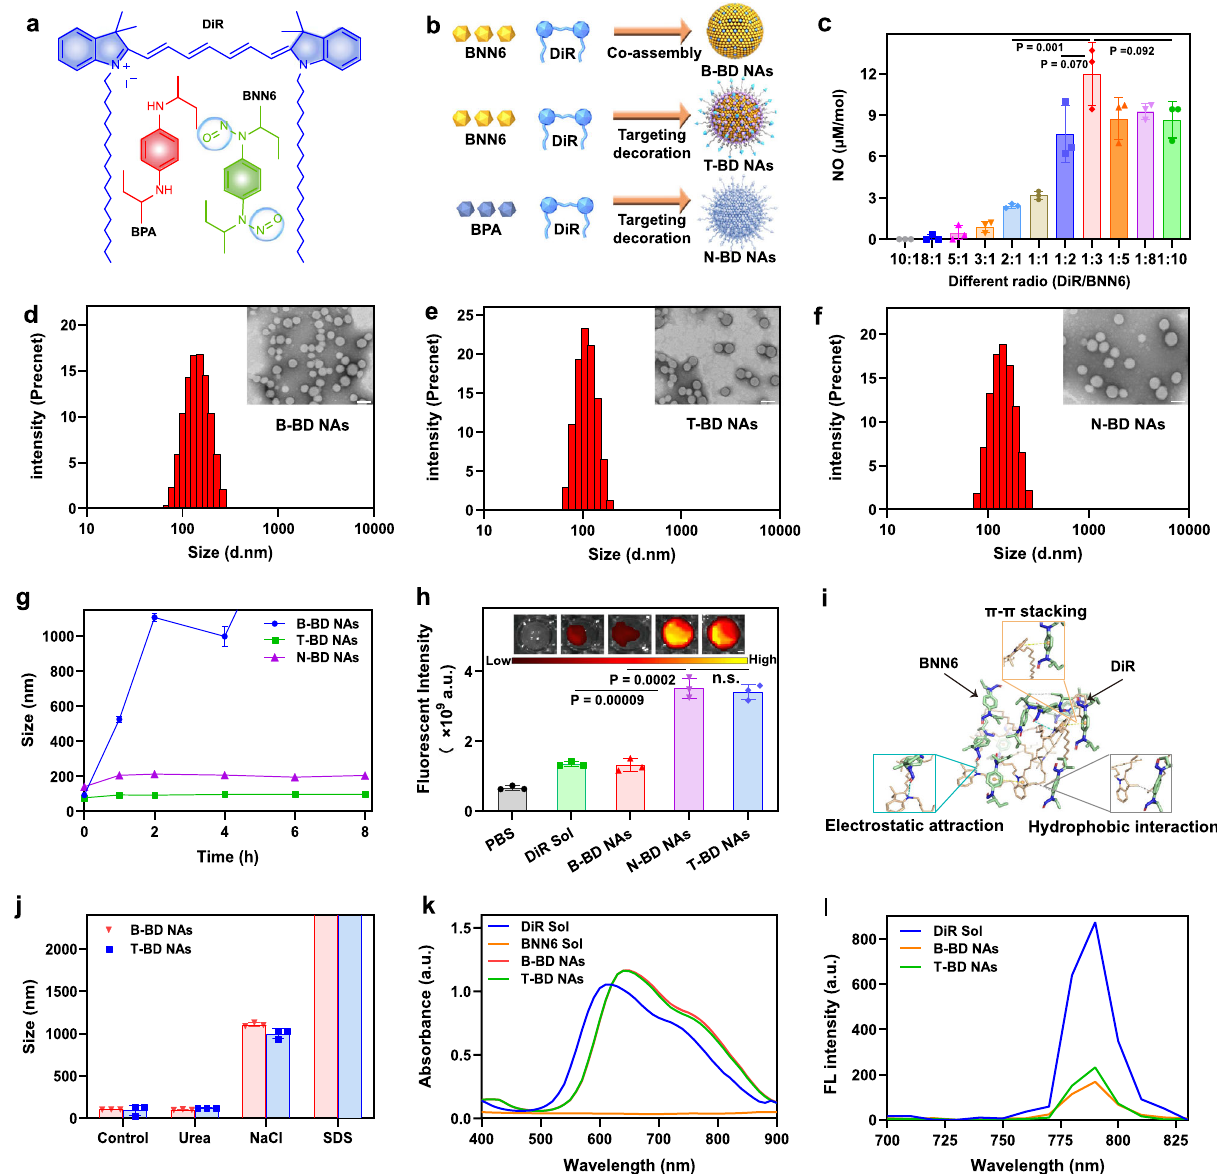
Fig. 2 | Elaborate engineering and characterization of fuel pair nano- penetrator. a Chemical structure of DiR, BNN6 (NO donor), and BPA (BNN6 pre- cursor without NO production ability). b Co-assembly process of the binary NAs. c NOgeneration from B-BD NAsatvarious molar ratios of DiR and BNN6 from 10:1 to 1:10. Data are presented as mean±SD ( n =3, independent experiments). Source dataareprovidedasaSourceData fi le.One-wayANOVA(one-sided)withDunnett ’ s multiple comparisons test was used for the analysis of data and adjusted P value. d – f Particle sizesdistribution pro fi lesand TEM imagesof B-BDNAs, T-BDNAs, and N-BDNAs,respectively,(Scalebar=100nm).Experimentwasrepeatedthreetimes independently with similar results. g Colloidalstability of B-BDNAs, T-BDNAs,and N-BD NAs incubated in PBS (pH 7.4) within 8h at 37° C. Data are presented as